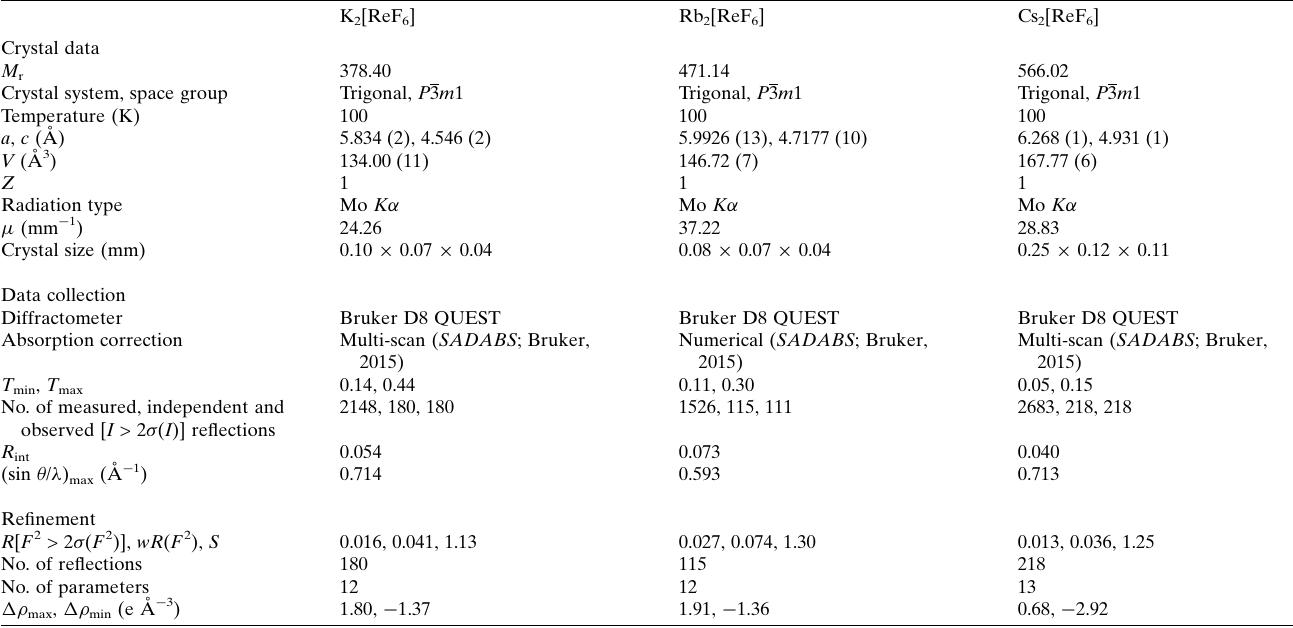
Table 2 Experimental